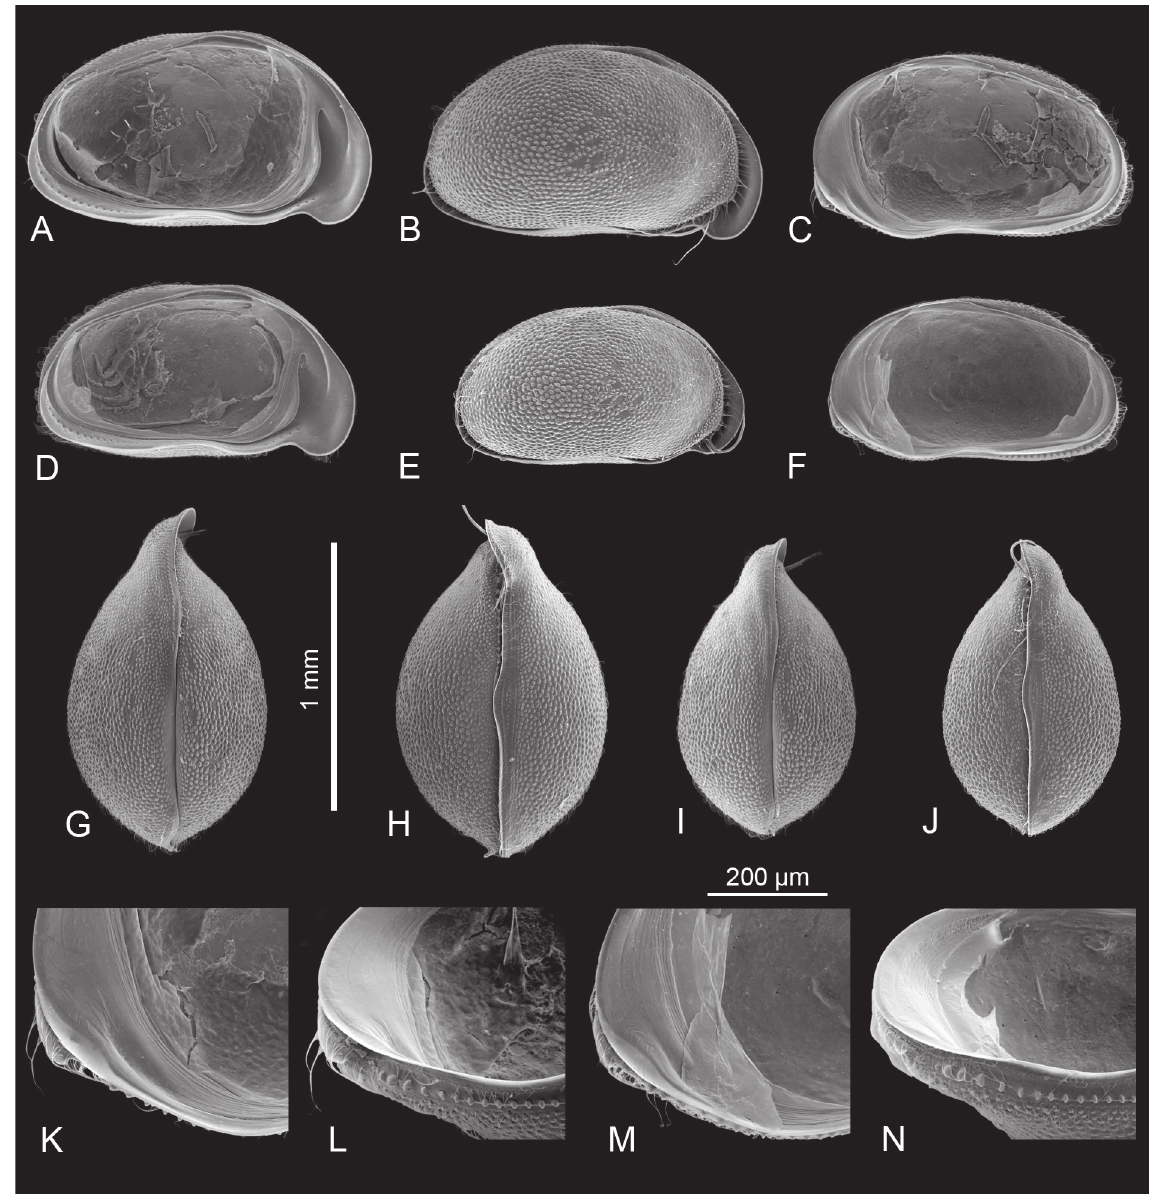
Fig. 5. Bennelongia tirigie sp. nov. (all from type locality: tirigie claypan, Murchison/Gascoyne, WA). A . LVi (allotype ♀, WAMC55596). B . CpRL (♀, WAMC 55600). C . RVi (♀, WAMC55596). D . LVi (holotype ♂, WAMC55595). E . CpRL (♂, WAMC55597). F . RVi (♂, WAMC55595). G . CpD (♀, WAMC55599). H . CpV (♀, WAMC55598). I . CpD (♂, WAMC55597). J . CpV (♂, WAMC55597). K . RVi, detail anterior margin (♀, WAMC55596). L . rVi, tilted, detail anterior margin (♀, WAMC55596). M . RVi, detail anterior margin (♂, WAMC55595). N . rVi, tilted, detail anterior margin (♂, WAMC55595). Scale = 1 mm for A–J; 200 µm for